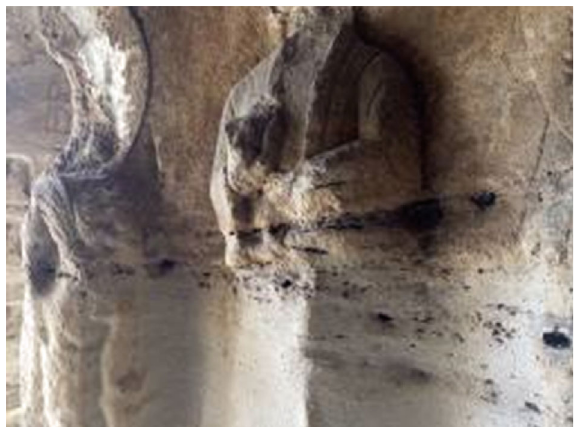
Figure 1: Local hole-like weathering in sculpture layer in Yungang